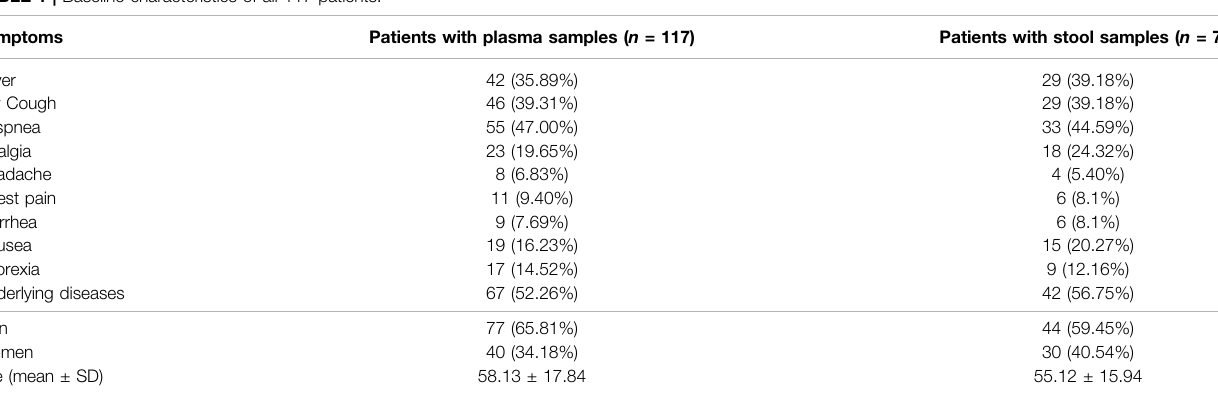
TABLE 1 | Baseline characteristics of all 117 patients.